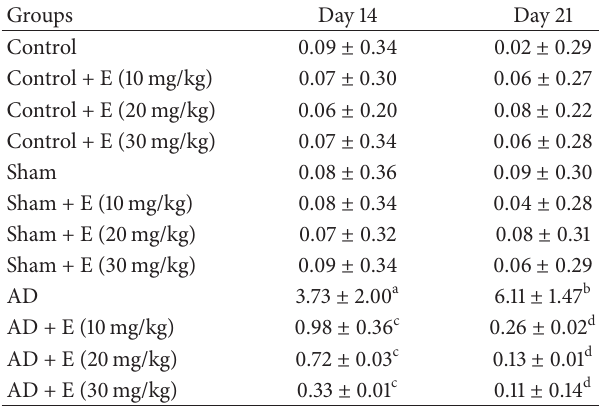
Table 1: The latency of first entry to the inner area in an elevated open space with a novel object (for anxiety status) of different experimental groups of